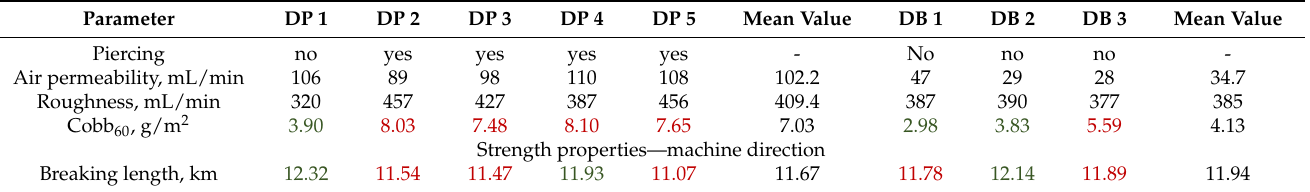
Table 6. Sensory evaluation of the dispersion samples (before the coating process) and properties of the coated